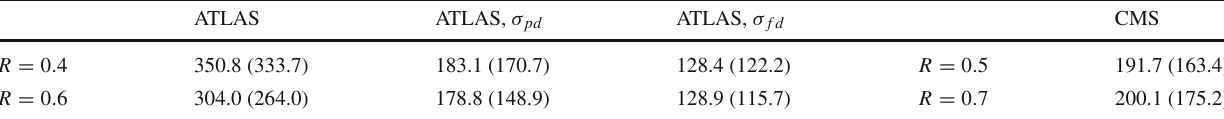
Table 3 The χ 2 for the combined fit to the ATLAS ( N pts = 140) and CMS ( N pts = 158) 7 TeV jet data. The values for the ATLAS and CMS contributions are given, for different choices of jet radius and scale, at NLO and NNLO